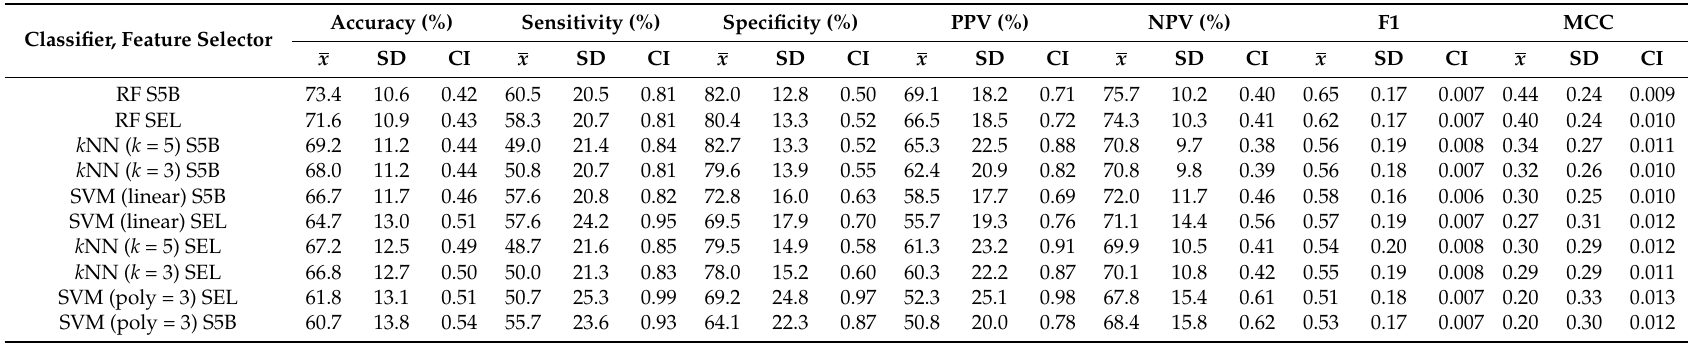
Table 4. Turn section results for 2500-iteration random-shuffle-split cross validation (2500-RSS), ordered by ranked performance. PPV: positive predictive value, NPV: negative predictive value, MCC: Matthews correlation coefficient, S5B: select-5-best method, SEL: false positive and discovery rate method, RFE: recursive feature eliminator, RF: random forest, k NN: k -nearest neighbour, SVM: support vector machine, linear: linear kernel, poly: polynomial kernel, x : mean, SD: standard deviation, CI: 95% confidence